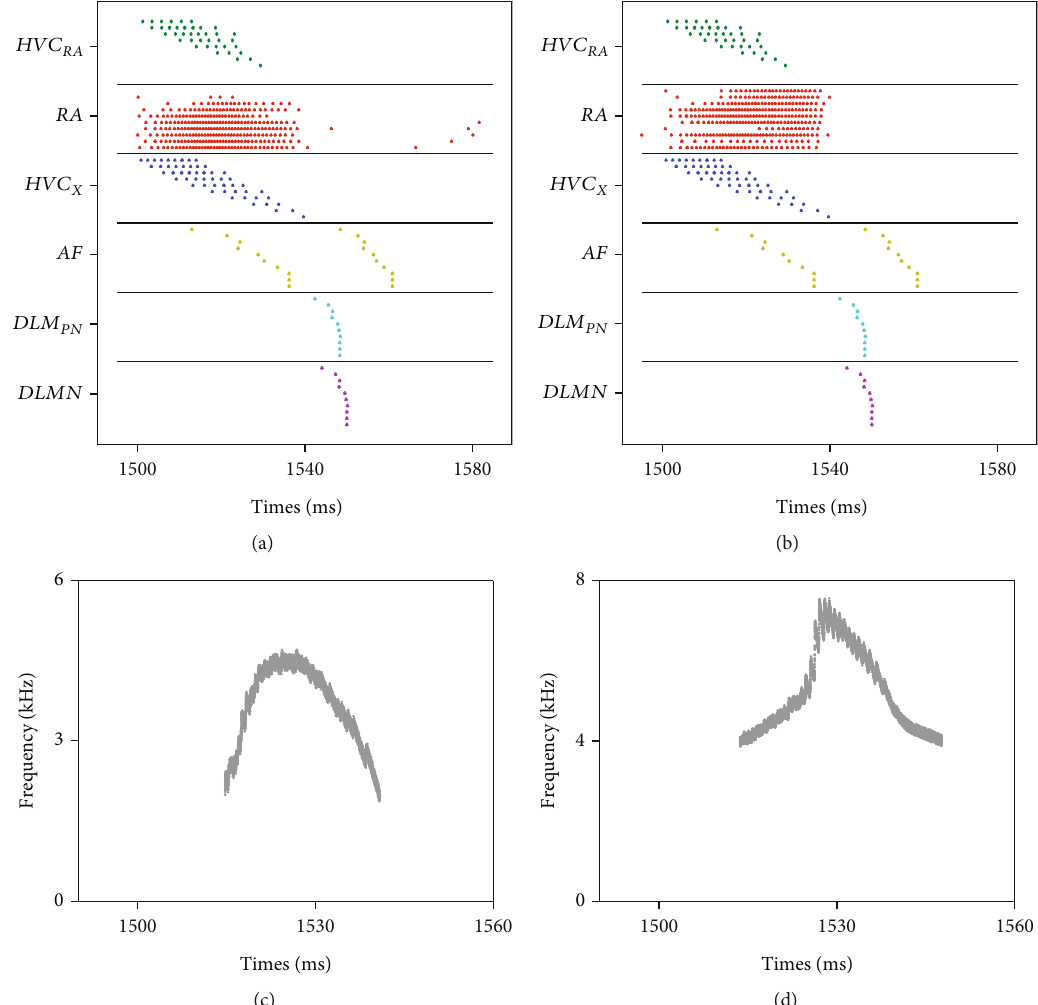
Figure 12: The raster plots and syllables at the fi rst trial and 200th trial. (a) and (b) show birdsong neural circuit activities before and after training, respectively, where each point represents a spike. (c) and (d) are the corresponding syllables with a basic frequency between 2 and